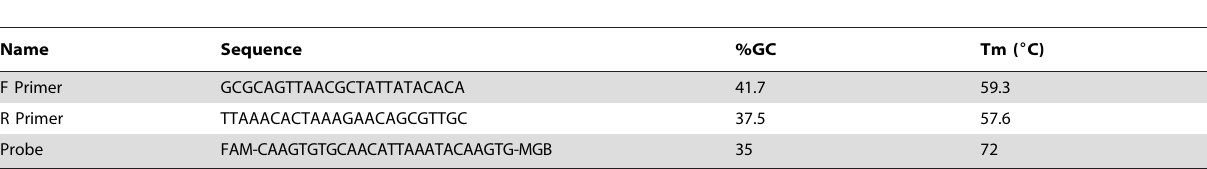
Table 1. Sequences and properties of real-time PCR primers and probe for 177 bp satellite